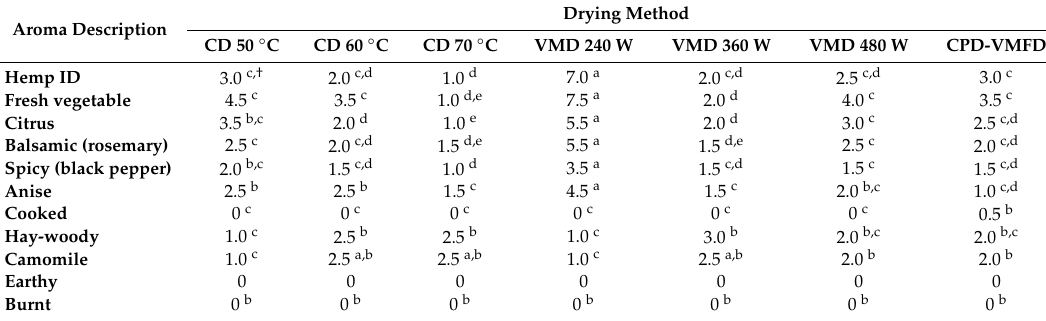
Table 5. Sensory profile of dried hemp